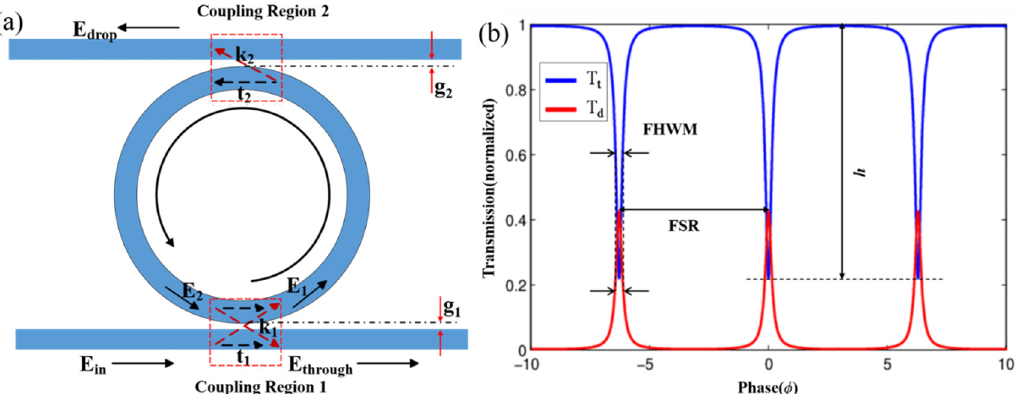
Figure 1. ( a ) Structural diagram of the transmissive ring resonator; ( b ) resonant spectrum of the resonator.